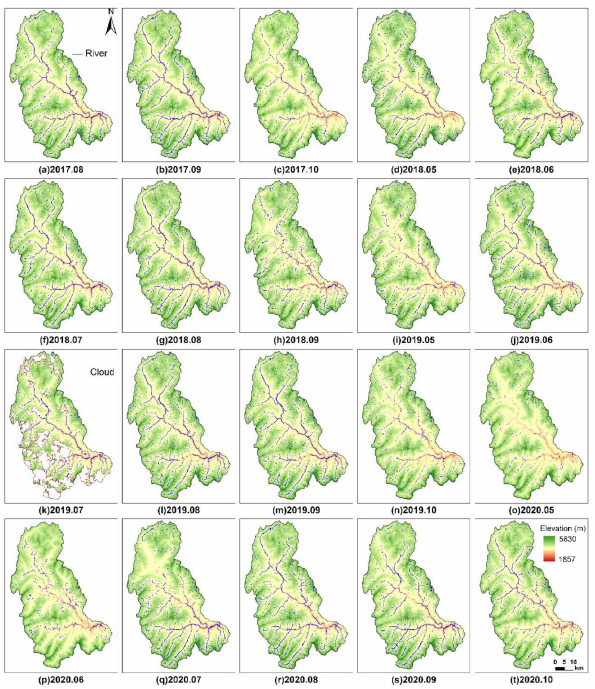
Figure 14. Remote sensing river network of the study area, 2017–2020. The cloud area of 2019.07 was cropped, and the remaining area was used to calculate the Dd and